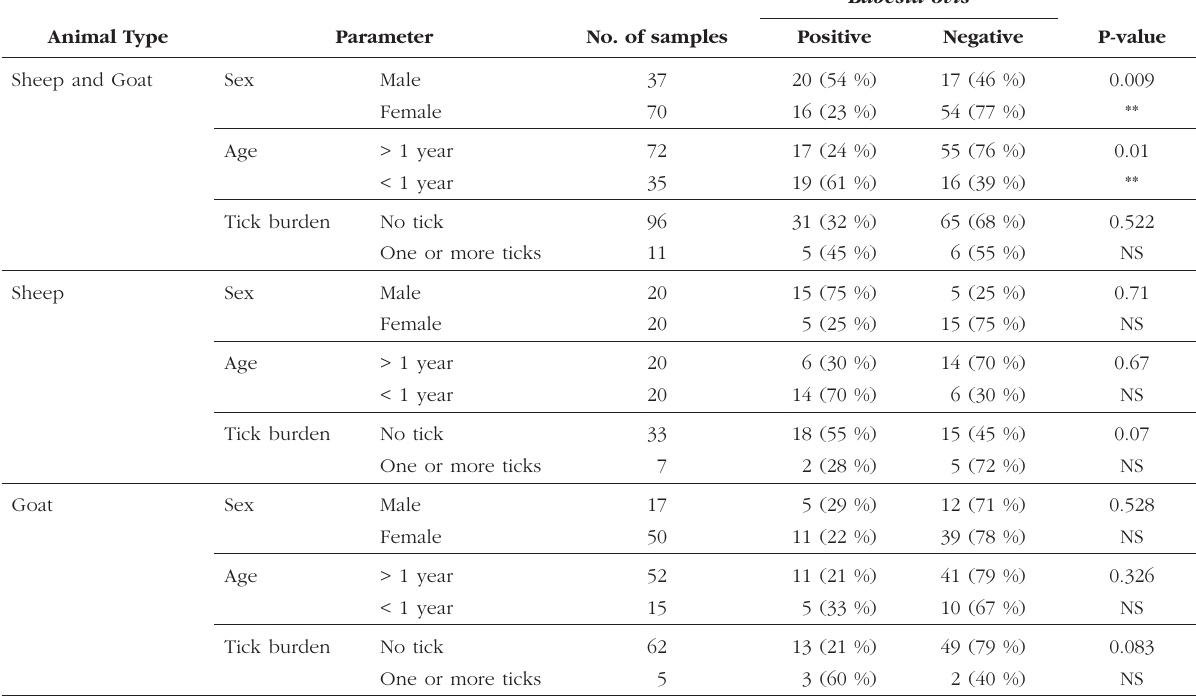
Table II. – Association between parasite prevalence in goats and sheep and the studied parameters describing animal characters.